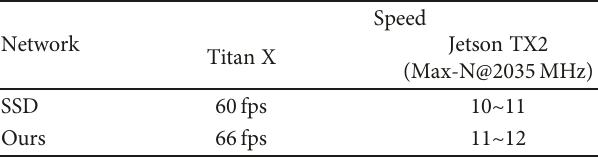
Table 3: Comparison of running speed.